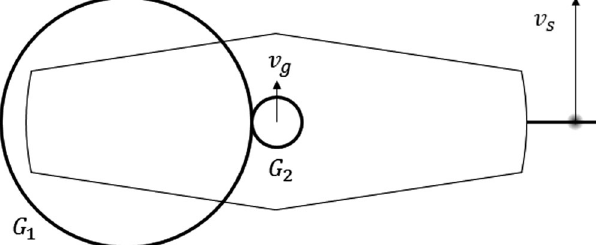
FIG. 1. A schematic representation of the wire scanner operation. The gear G 2 with the blade attached to it rotates around the stationary gear G 1 . The carbon fiber at the end of the blade intercepts the beam, producing a time-dependent signal proportional to the beam projection on a direction orthogonal to the fiber.